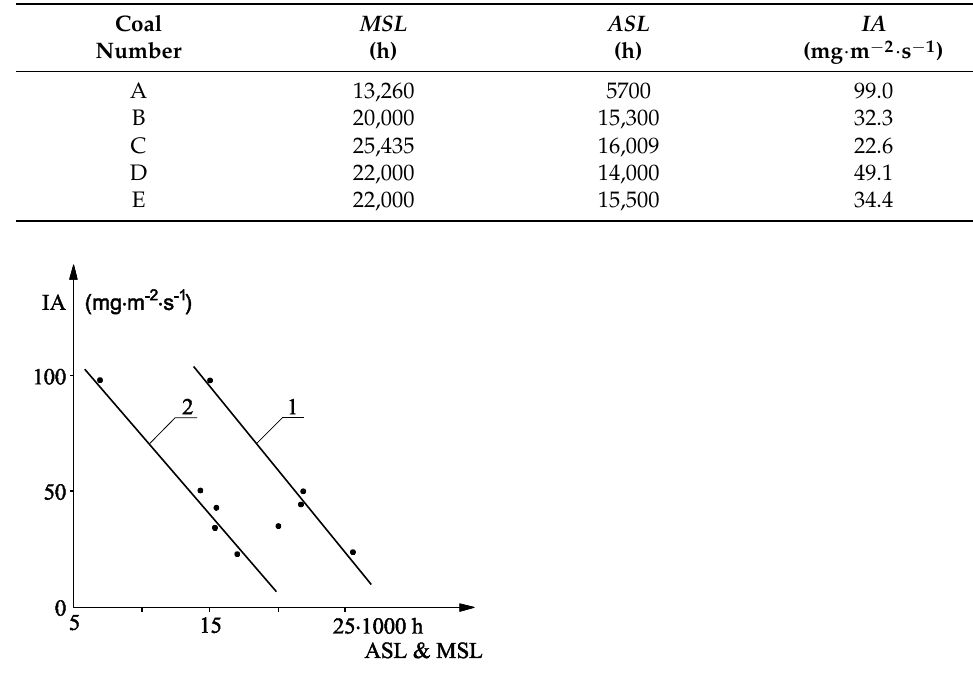
Figure A2. Correlation between IA and MSL and ASL, where 1 and 2 are the regression lines of the Equations MSL = 27,064 − 137 IA, and ASL = 19,976 − 140 IA, MSL is a maximum life of the bottom rings (h), ASL is an average life of the bottom rings (h), IA is intensity of abrasion (mg · m −2 · s −1 ).